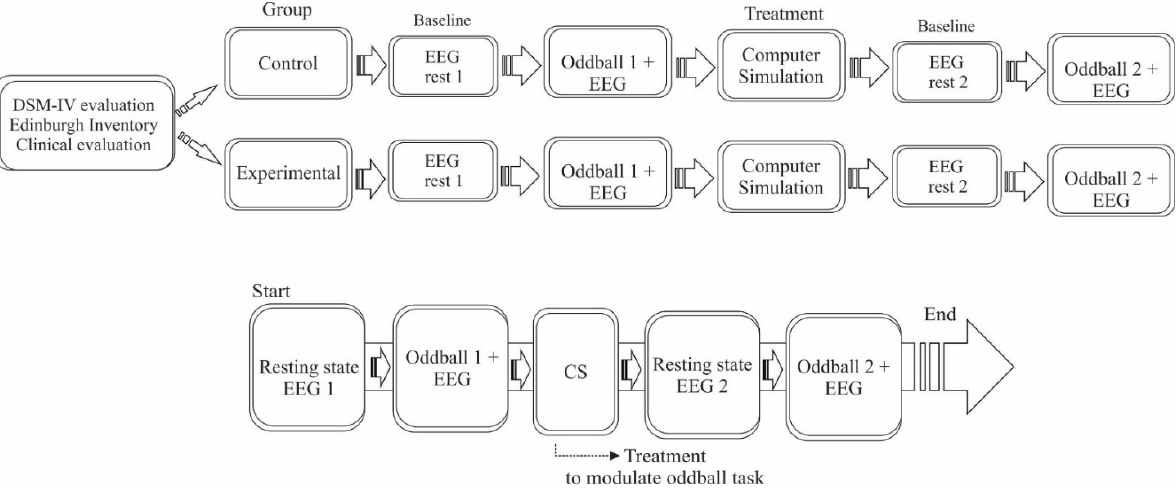
Figure 1. Illustration of the experimental procedure.